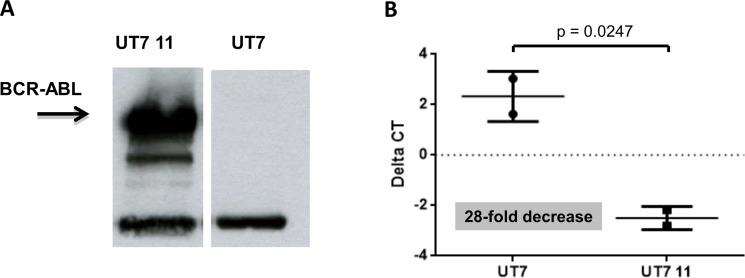
Expression of AHR in UT-7 cells and UT-7/11 cells.(A) Evaluation of the expression of BCR-ABL in the UT-7/11 cells as compared to the parental UT-7 cell line using Western blot analysis. As can be seen in this panel, BCR-ABL protein is highly expressed in the UT-7/11 cell line, with presence of some degradation products, which are visible. (B). Evaluation of the expression of the expression of AHR mRNA using Q-RT-PCR analyses. The expression of AHR is strongly downregulated in the BCR-ABL-expressing UT-7/11 cell line as compared to parental UT-7 cells. This difference is highly significant (t-test, p = 0.0247).